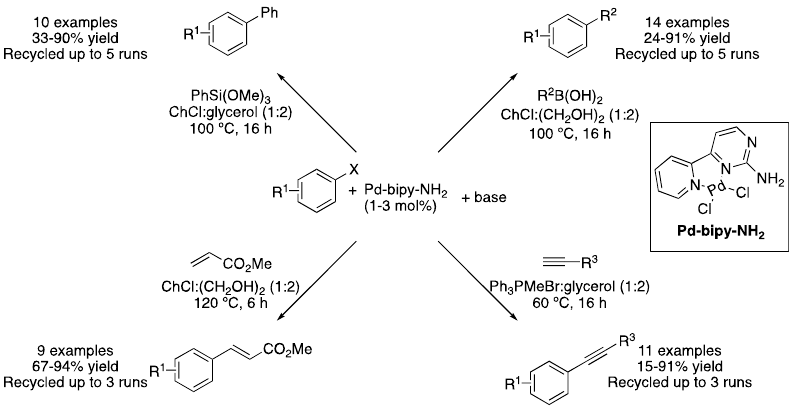
Figure 20. Pd-bipy-NH 2 based cross-coupling transformations.